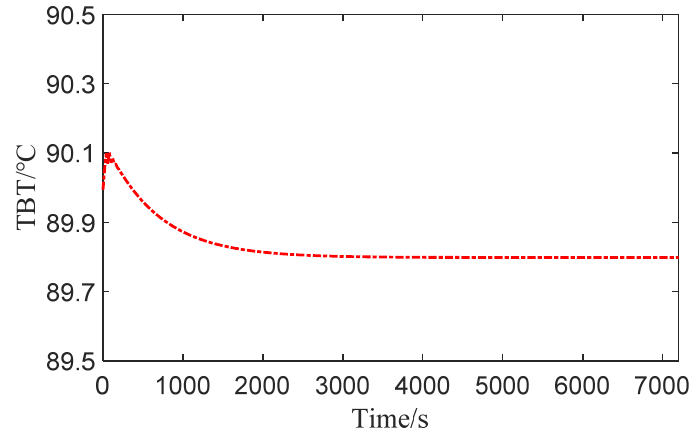
Figure 4. Top brine temperature ( TBT) dynamic response with time.